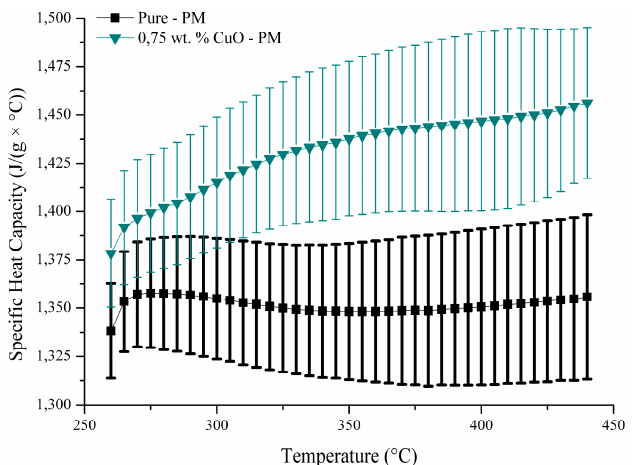
Figure 6. Specific heat capacity of the normal binary salt mixture against the enhanced mixture with 0.75 wt. % CuO using the powder mixing method.